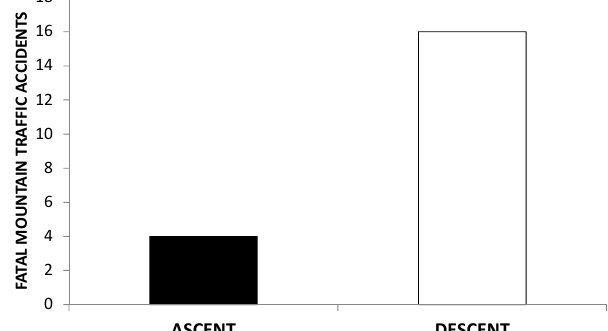
Figure 3. Fatal road traffic accidents in Chilean mining ( n = 18) and Atacama Large Millimeter Array (ALMA) Observatory ( n = 2) between the years 2005 and 2017. Column on the left ( n = 4) and the right ( n = 16), respectively, indicate the number of cases that occurred during ascent and descent (De Gregorio, N (Faculty of Medicine, University of Chile. Santiago, Chile). Unpublished results. 2020).